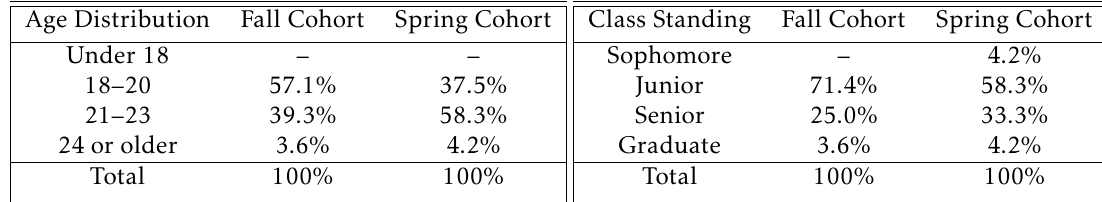
Table 1. Demographics of the Fall and Spring cohorts: age distribution, and class standing.